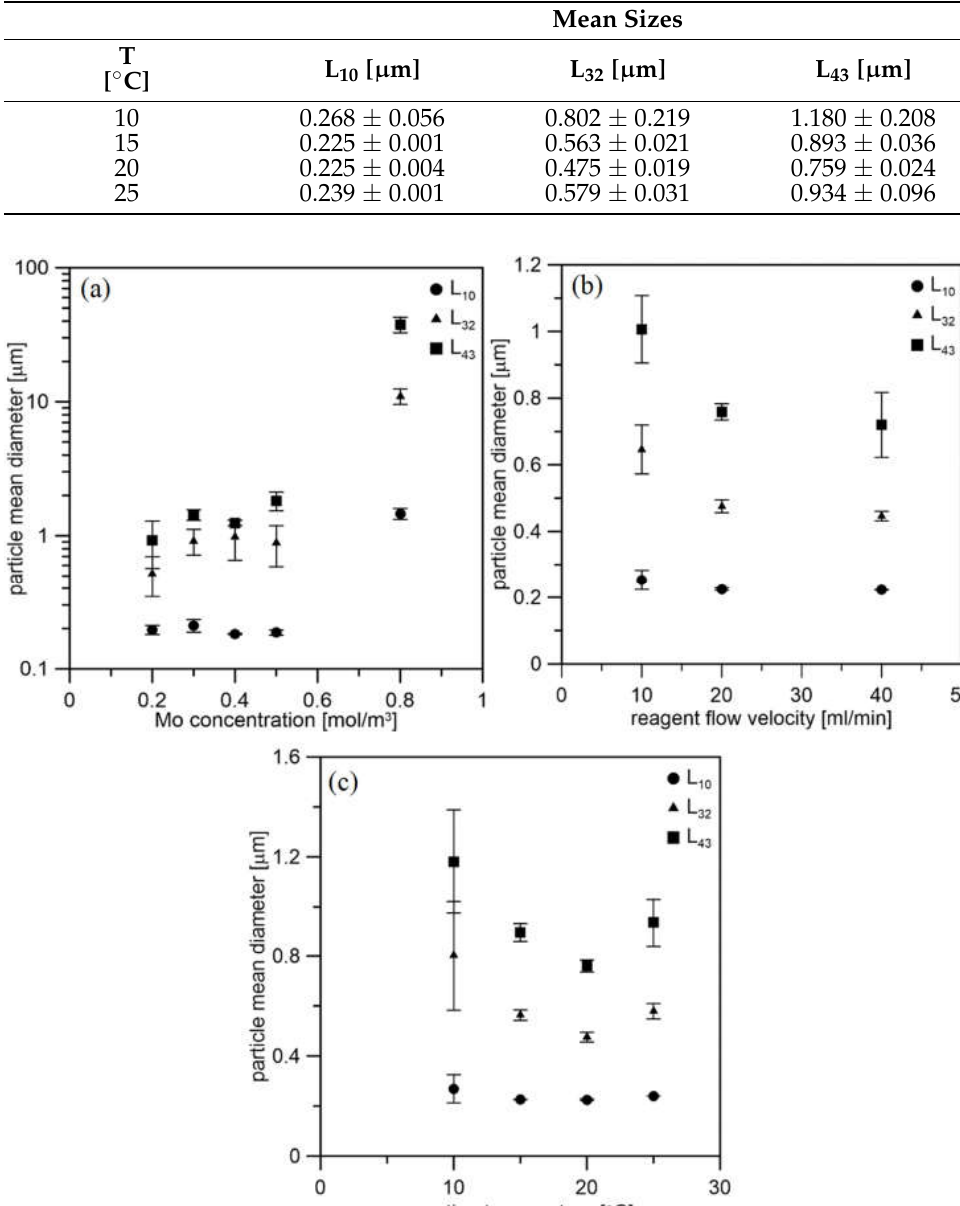
Figure 7. Effect of the process conditions on particle mean size. ( a ) Initial molybdenum concentration at 20 °C and with flow velocity of 20 mL/min, ( b ) reagent flow velocity at 20 °C and with Mo concentration of 0.2 mol/m 3 , ( c ) reaction temperature with flow velocity of 20 mL/min and with Mo concentration of 0.2 mol/m 3 .